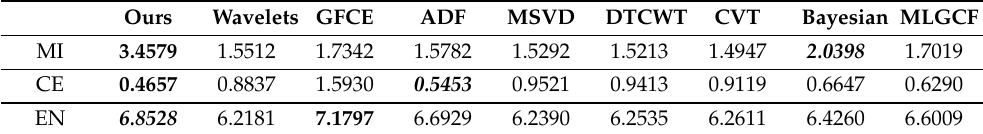
Table 2. Objective values of nato With different